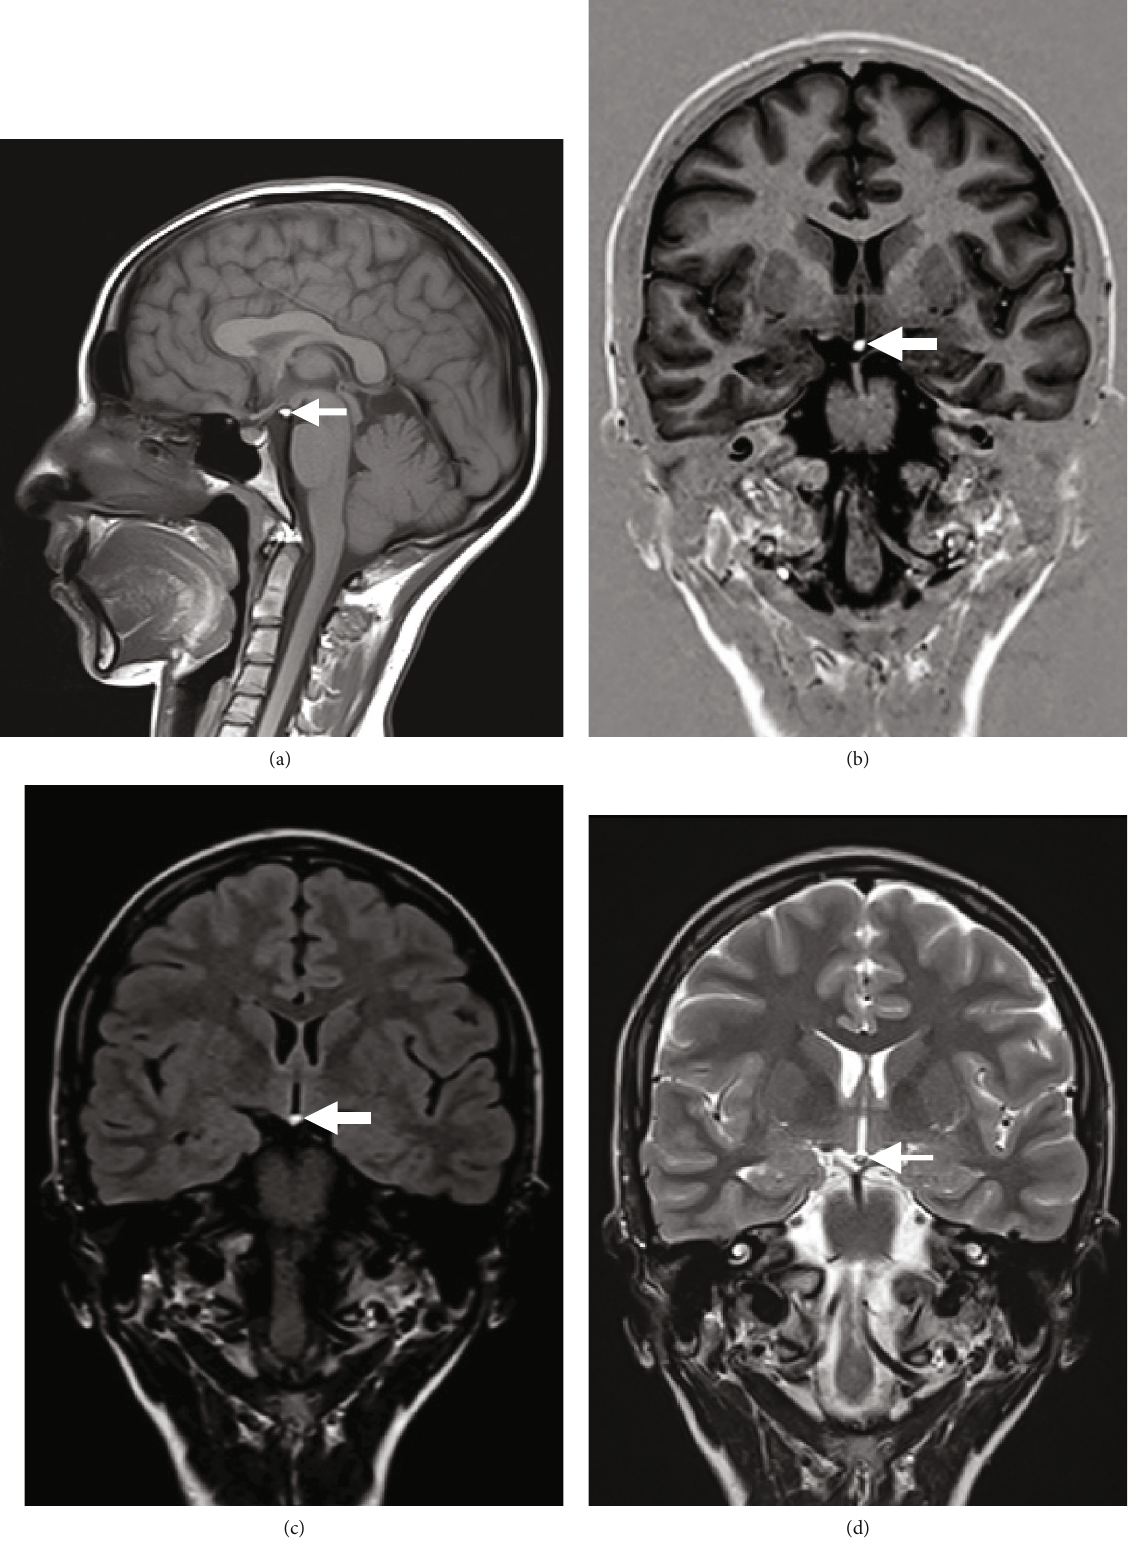
Figure 4: (a) Sagittal T1-weighted MRI. (b) Coronal T1-weighted gradient MRI (FSPGR). (c) Coronal FLAIR T2-weighted MRI. (d) Coronal T2-weighted image. (a) – (d) A small hypothalamic lipoma is noted, following fat signal on all